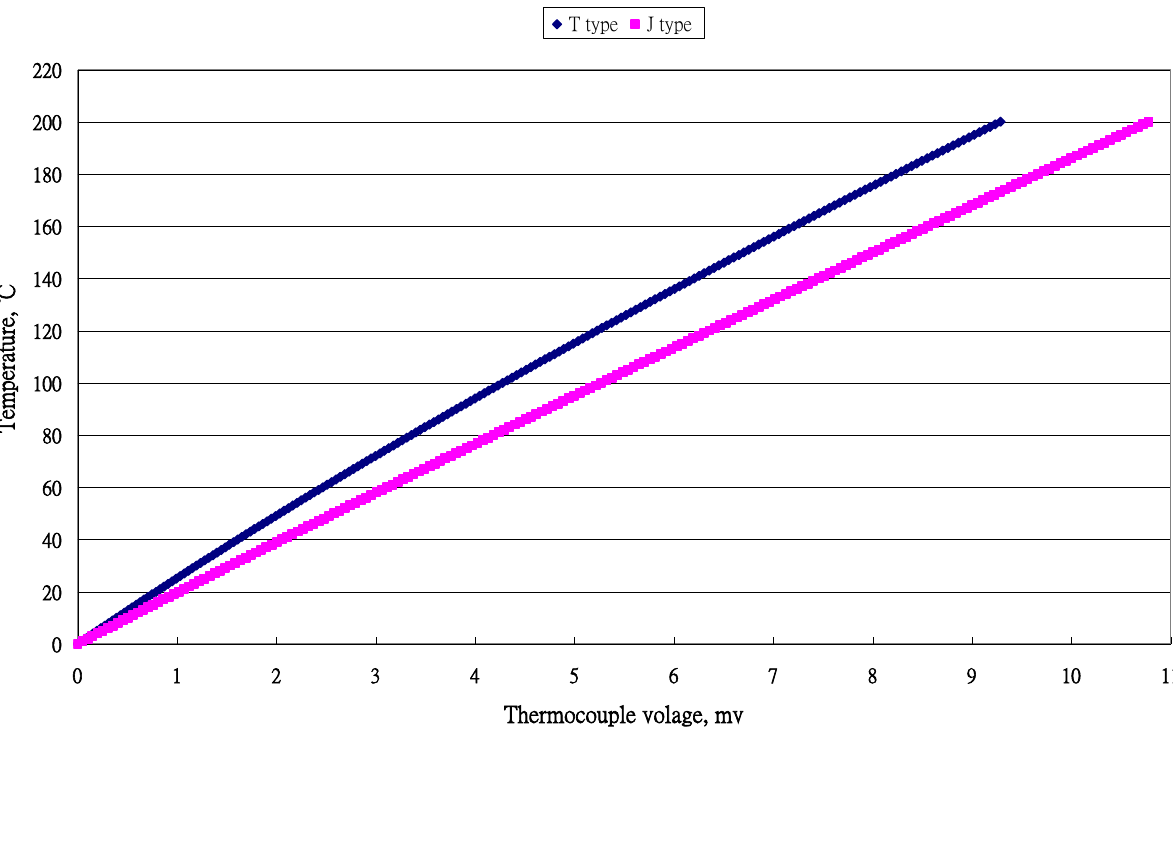
Figure 1. Distribution of temperature and output voltage of two types of thermocouples with temperature (0 to 200 °C)